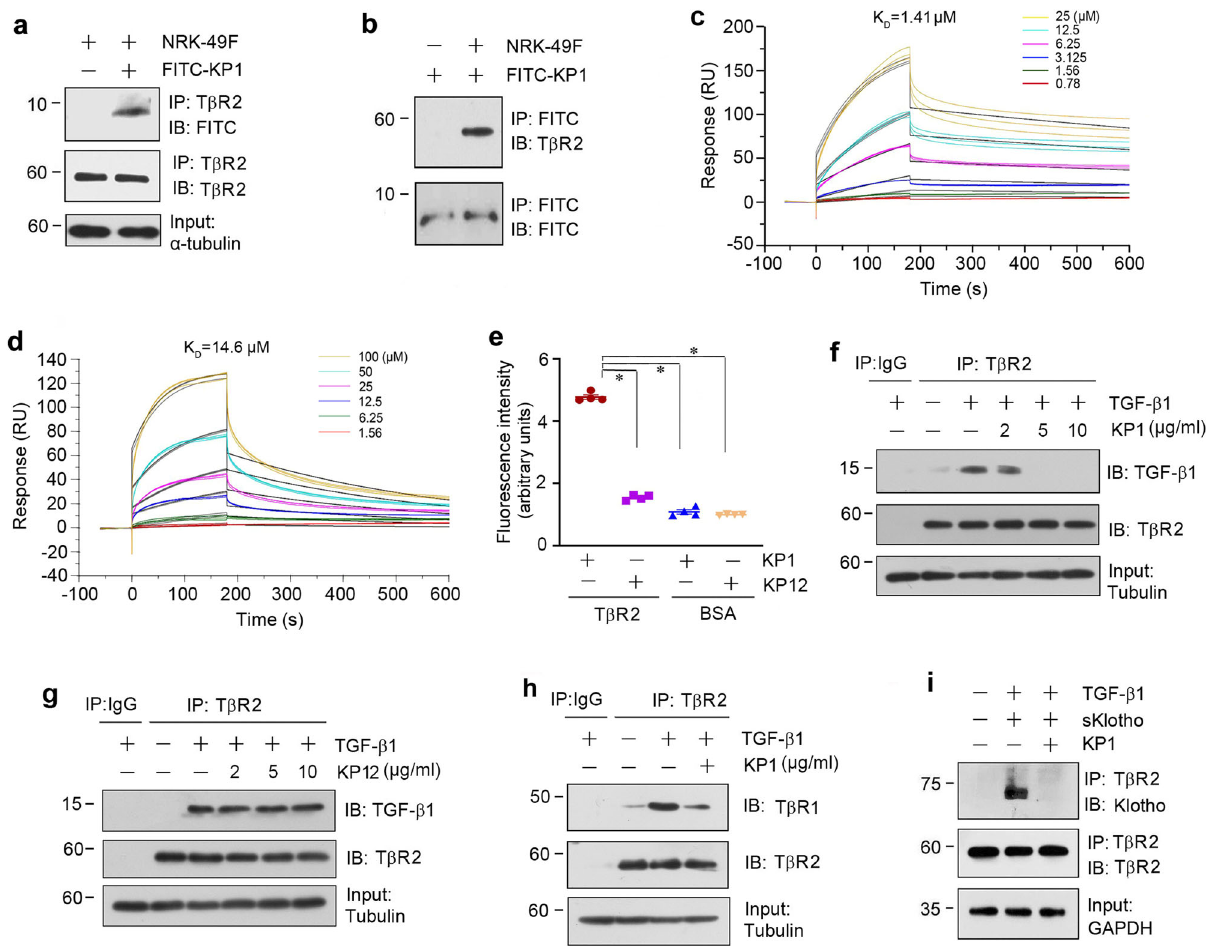
Fig. 2 KP1 competes with TGF- β 1 for T β R2 binding. a , b Co-immunoprecipitation (Co-IP) demonstrated that KP1 bound to T β R2. NRK-49F cell lysates (500 µ g) and FITC-KP1 (10 µ g) were immunoprecipitated (IP) with the anti-T β R2 antibody at 4 °C overnight, followed by immunoblotted (IB) for FITC and T β R2, respectively ( a ). In the reciprocal experiment, mixtures of cell lysates and FITC-KP1 were immunoprecipitated with anti-FITC, followed by immunoblotted for T β R2 and FITC ( b ). c The af fi nity of T β R2 to KP1 was shown. SPR analyses showed concentration-dependent (0.78 – 25 μ M) binding of KP1 to T β R2 immobilized on a sensor chip. A representative sensorgram of two independent experiments is presented, in which the curves (color) with an overlay of the fi tting (black) are shown. The fi tted constants are k a = 407.7 M − 1 S − 1 ; k d = 5.8 × 10 − 4 S − 1 ; K D = 1.4 × 10 − 6 M. d The af fi nity of T β R2 to KP12 was shown. SPR analyses showed concentration-dependent (1.56 – 100 μ M) binding of KP12 to T β R2 immobilized on a sensor chip. A representative sensorgram of two independent experiments is presented, in which the curves (color) with an overlay of the fi tting (black) are shown. The fi tted constants are k a = 159.5M − 1 S − 1 ; k d = 2.3 × 10 − 3 S − 1 ; K D = 14.6 × 10 − 6 M. e The speci fi c binding of FITC-KP1 to T β R2 coated on a microplate. The fl uorescence intensity of FITC-KP1 (arbitrary units) was assessed after incubating on a microplate coated with T β R2 protein. P values (from left to right): <0.001, <0.001, and <0.001 (one-way ANOVA with Fisher ’ s LSD post hoc test). ( n = 4 biologically independent cells). Data are presented as mean values ± SEM. f KP1 inhibited the interaction between T β R2 and TGF- β 1 dose-dependently. NRK-49F cells were pre-incubated with different amounts of KP1 for 1 h, and then treated with TGF- β 1 (2 ng/ml) for 5 min. Cells were collected and immunoprecipitated with anti-T β R2 or anti-IgG. g Negative peptide KP12 did not block the binding of T β R2 and TGF- β 1. h KP1 inhibited the binding of T β R1 and T β R2. i KP1 inhibited the interaction of T β R2 and sKlotho. Cells were transfected with sKlotho plasmid for 24 h and incubated with TGF- β 1 in the absence or presence of KP1. Cells were collected and immunoprecipitated with anti-T β R2. Source data are provided as a Source Data fi